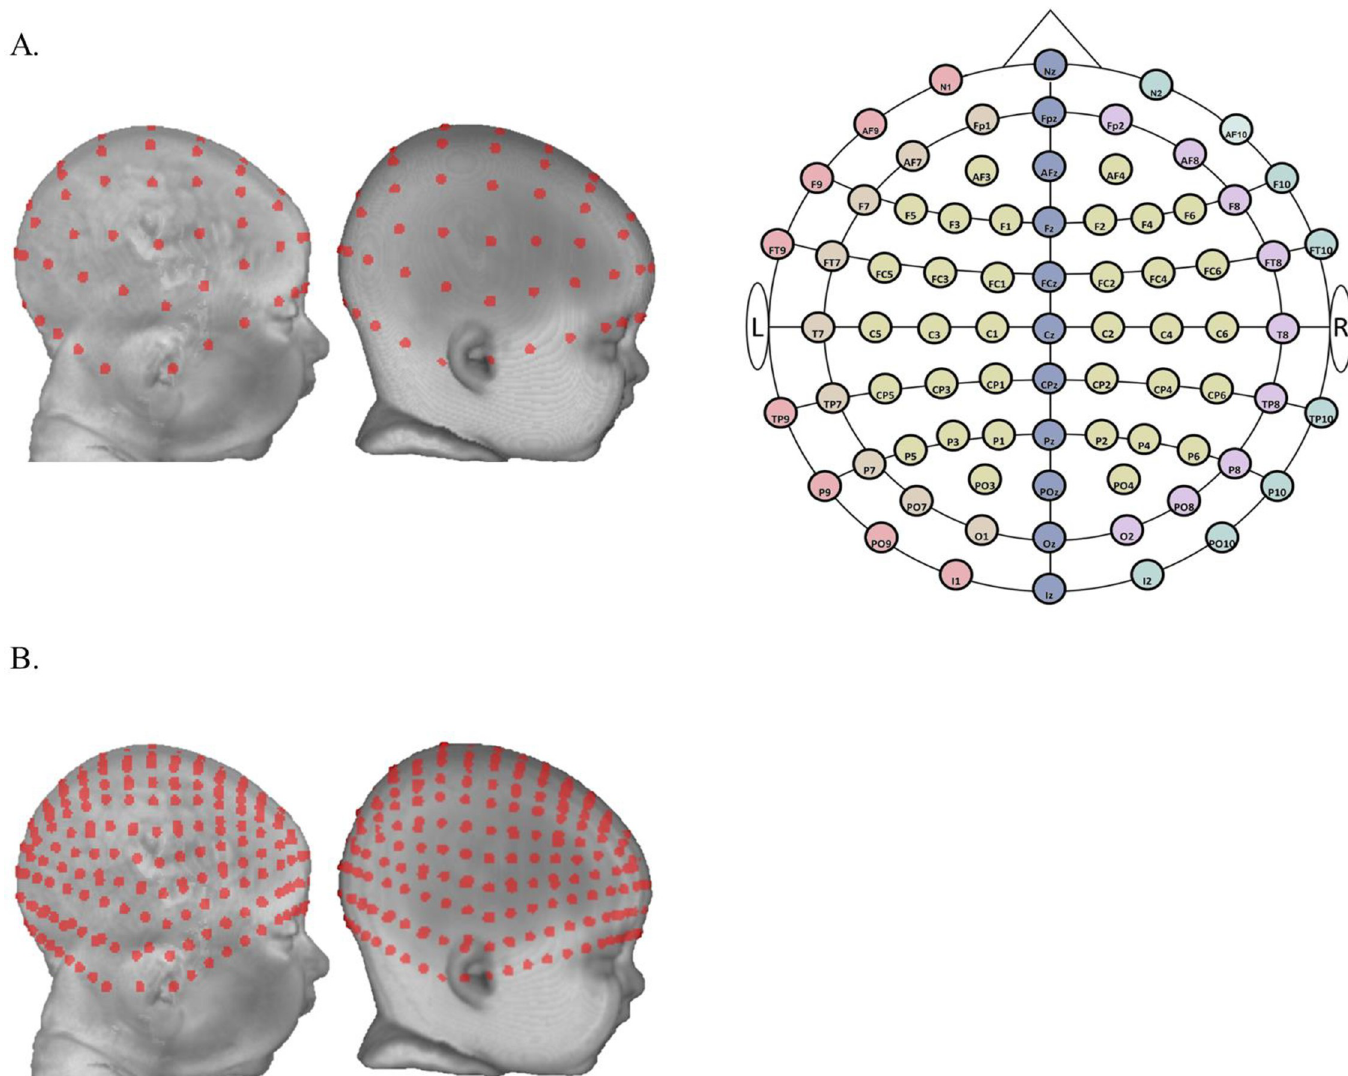
Fig 2. Virtual optodes placement. A. Virtual optodes placement on the standard 10–10 electrode system. From left to right: a three-month individual head model, an average template for three-month-old’s, and a two-dimensional layout of the 10–10 system). Ten-ten electrodes were divided into six groups for visualization purposes. The six groups were color-coded on the two-dimensional schematic of the 10–10 system. Group 1: electrodes on the central curve (Nz-Cz-Iz). Group 2: electrodes on the left curve between Nz and Iz (N1-LPA/T9-I1). Group 3: electrodes on the right curve between Nz and Iz (N2-RPA/T10-I2). Group 4: electrodes on the left curve between Fpz and Oz (Fp1-T7-O1). Group 5: electrodes on the right curve between Fpz and Oz (Fp2-T8-O2). Group 6: the remaining electrodes enclosed by the central curve, the left and right curves between Fpz and Oz. B. Virtual optodes placement on the 10–5 electrode system. From left to right: the same three-month individual head model and the three-month average